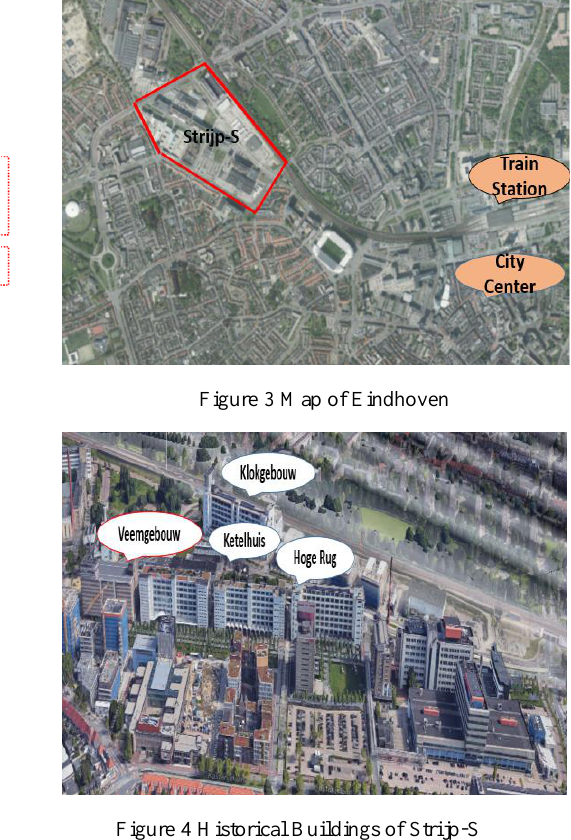
Figure 4 Historical Buildings of